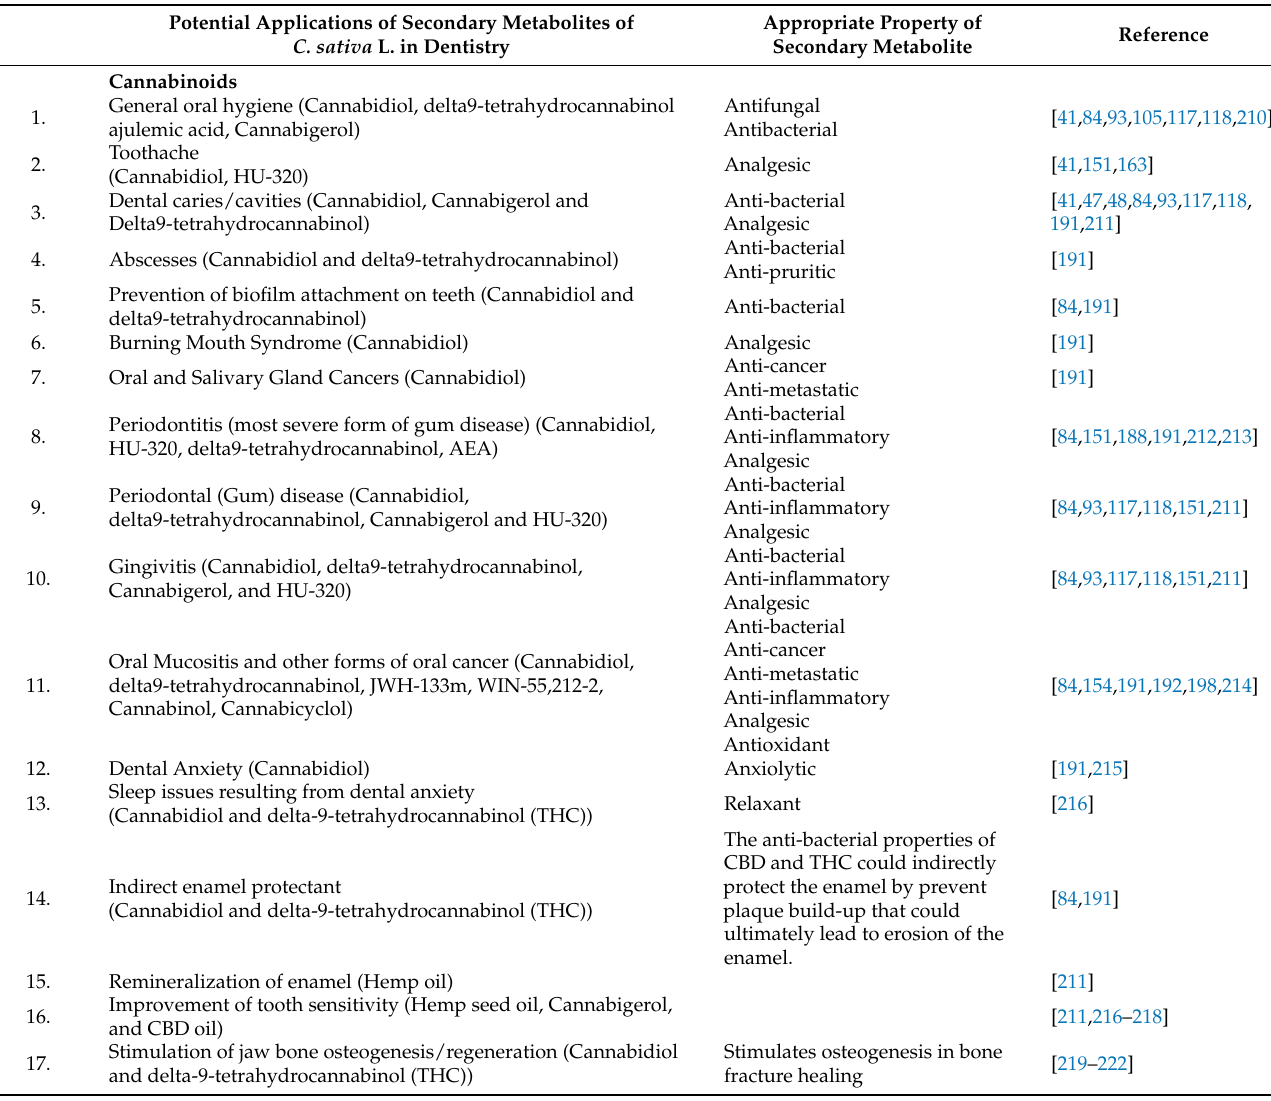
Table 4. Potential Applications of secondary metabolites of C. sativa L. in